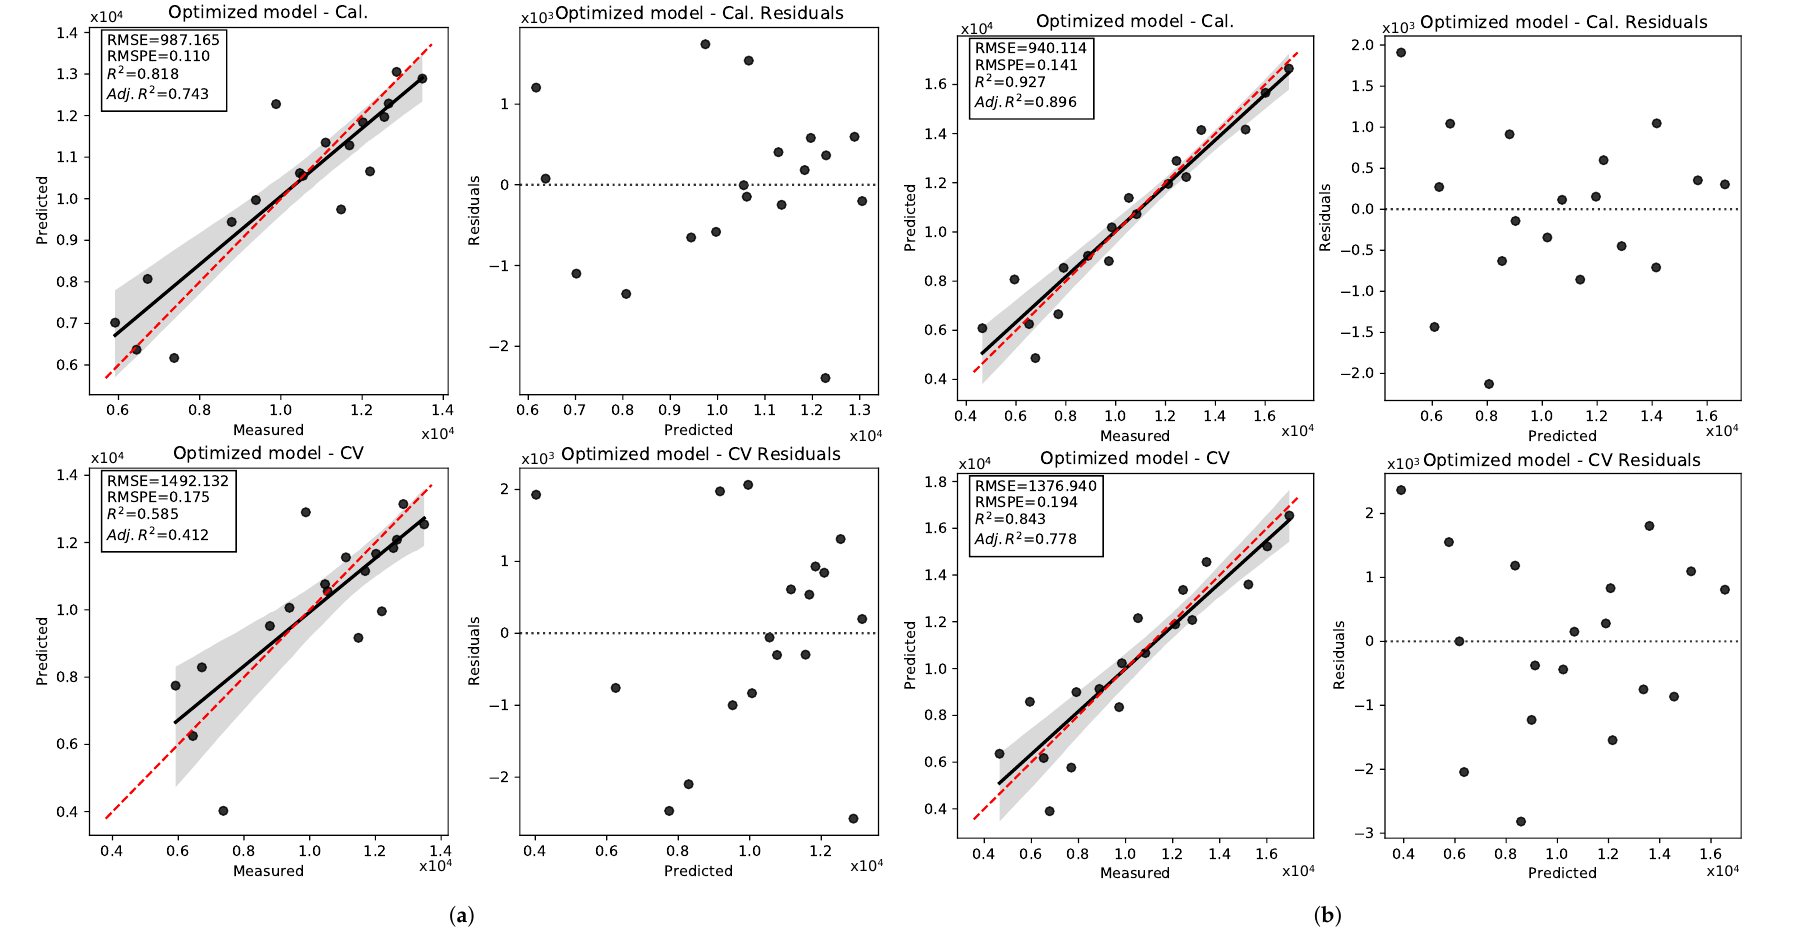
Figure 13. Regression results for snap bean 2020 data set on ( a ) the ACO-SAM model at 44 DAP for early harvest stage and ( b ) the ACO-SAM model at 58 DAP for the late harvest